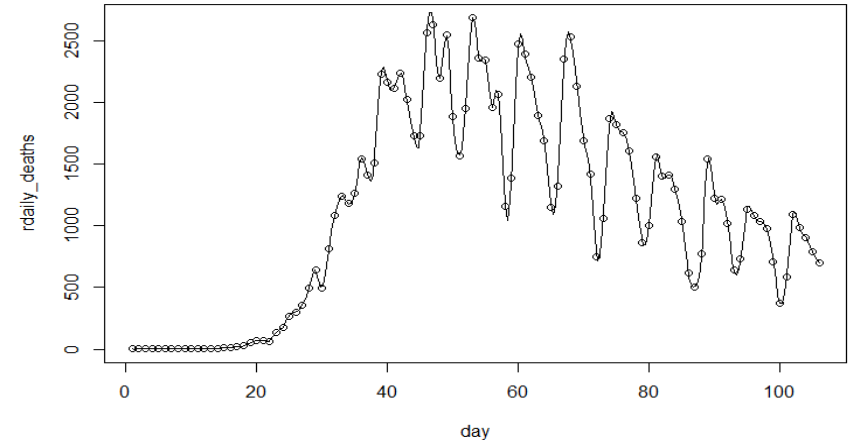
Figure 2. Daily death toll vs day in the United States